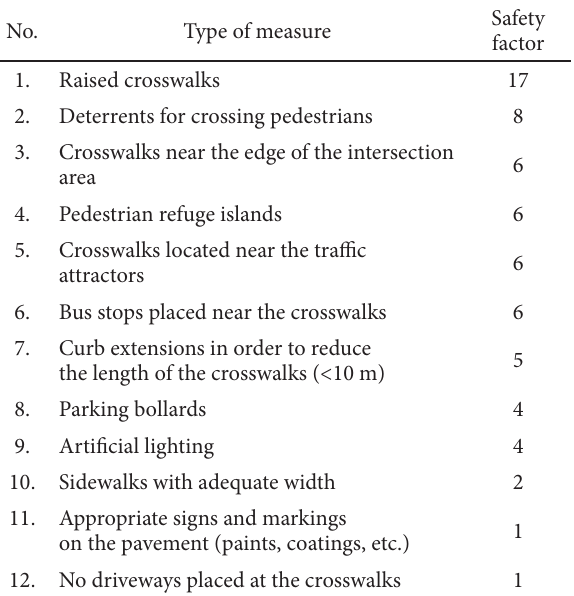
Table 4. Matrix of safety